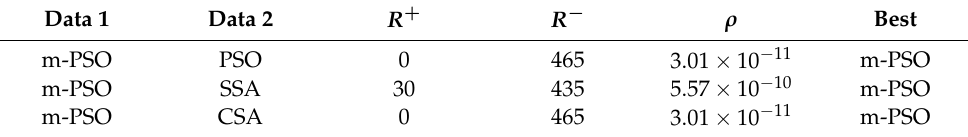
Table 5. Nonparametric comparatives with PSO, SSA, and CSA.